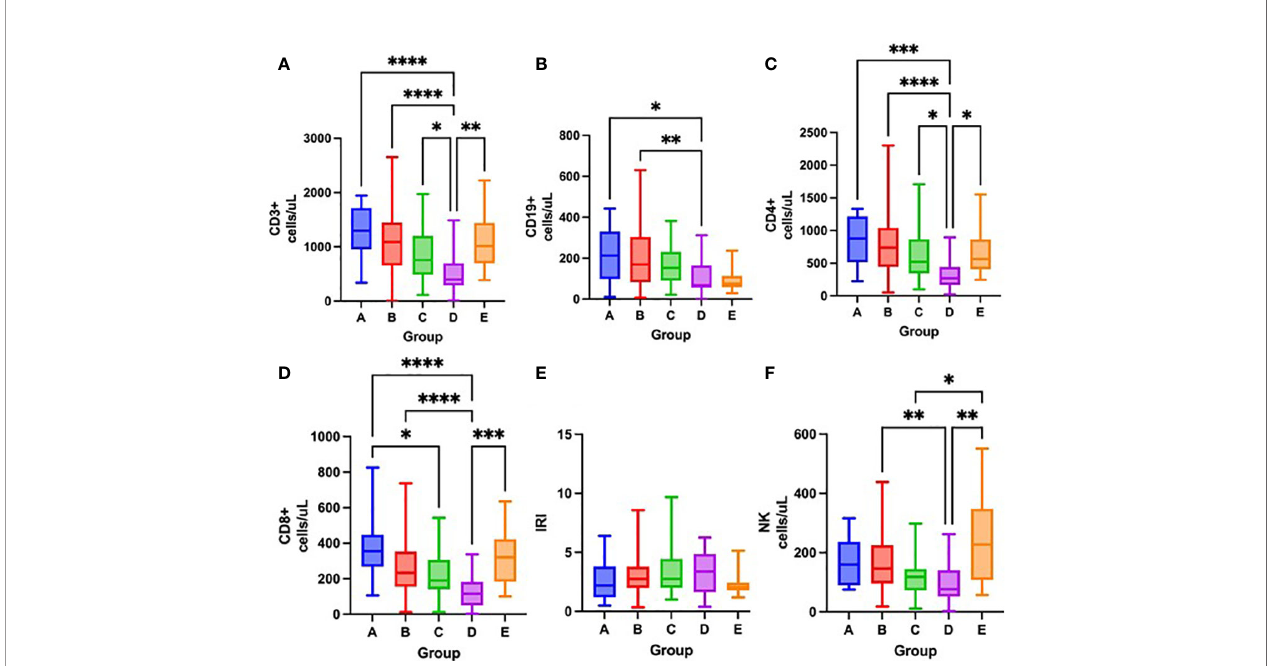
FIGURE 6 | Differences in the total number of lymphocyte subpopulations measured by fl ow cytometry – CD3 + cells (A) , CD19 + cells (B) , CD4 + cells (C) , CD8 + cells (D) , IRI immunoregulatory index CD4 + /CD8 + ) (E) , NK cells (F) among groups A – E after one week of hospitalization, Kruskal-Wallis test. *p < 0.05; **p < 0.01; ***p < 0.001; ****p <